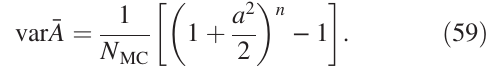
FIG. 12. Integrals Q for the SIAM model. The green and orange colors correspond Q 10 < 0 and Q 10 > 0 ,